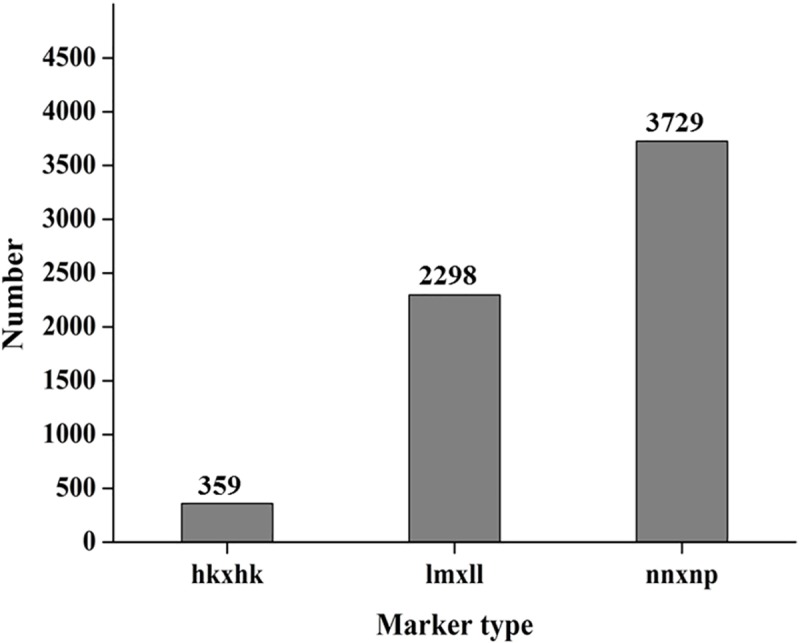
Number of different genotype markers.lm×ll represent the markers used for female map construction and the order was male×female, nn×np represent the markers used for male map construction and the order was female×male, hk×hk represent the markers contained by both of the parents.